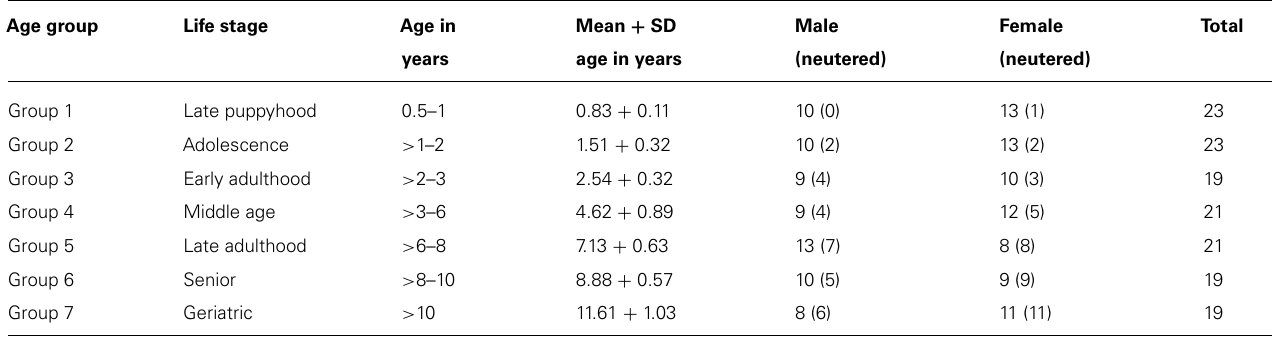
Table 1 |Age, sex, and reproductive status of